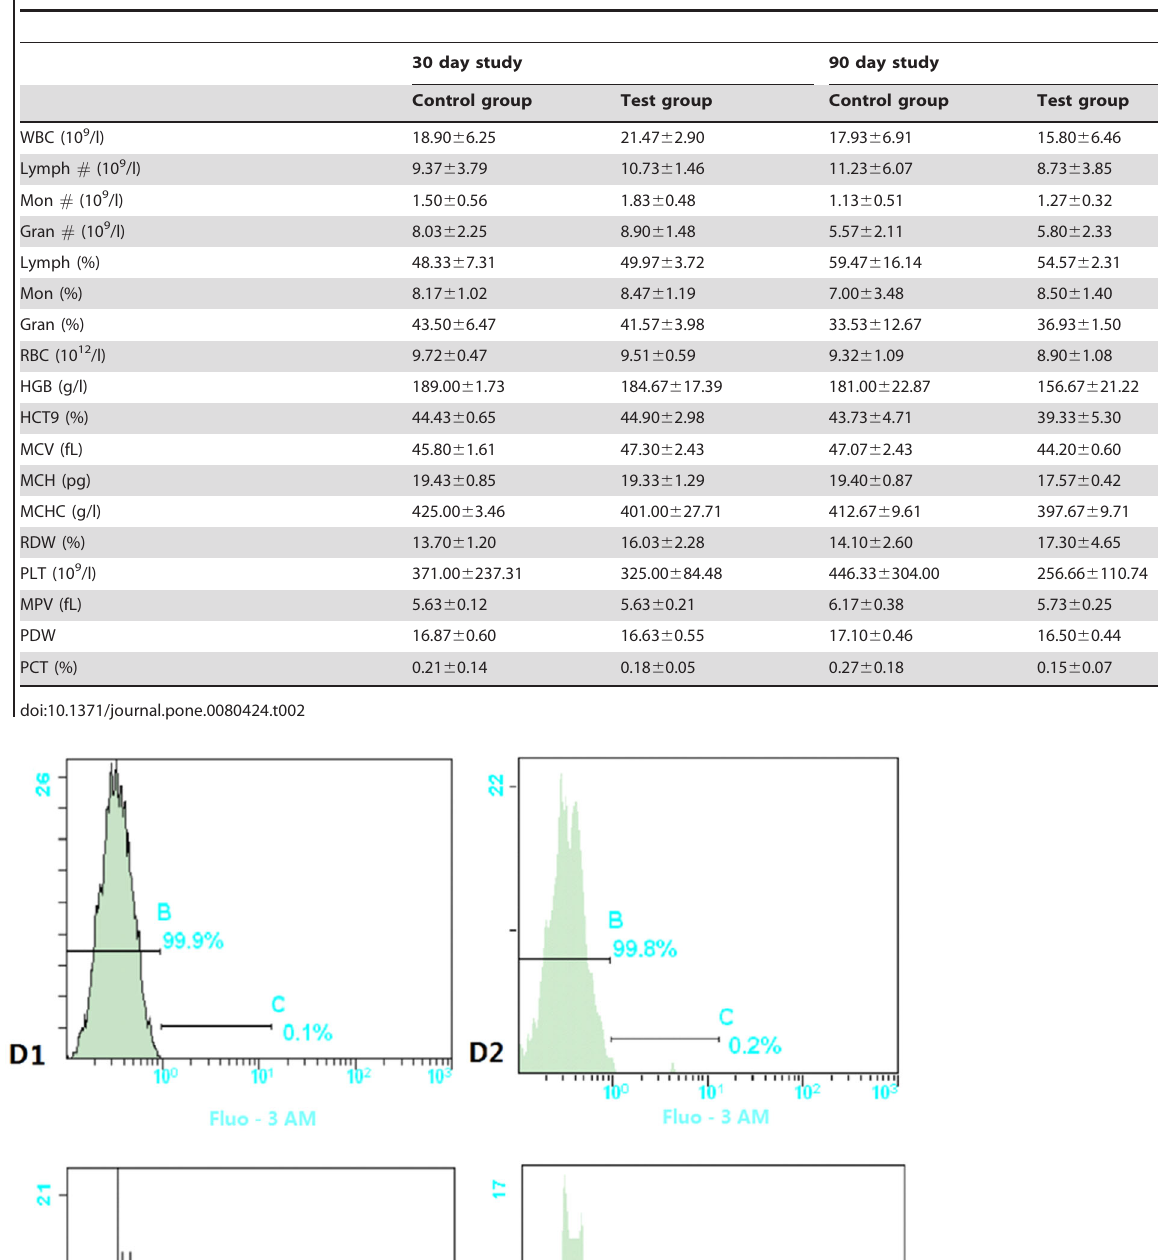
Table 2. Effects of transgenic Bt rice on the hematological indicators of rats.